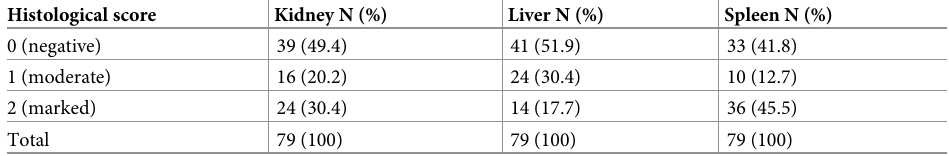
Table 2. Histological score of liver, spleen, and kidney samples positive to Congo red staining and showing bire- fringence under polarized light microscopy in in 79 cats.